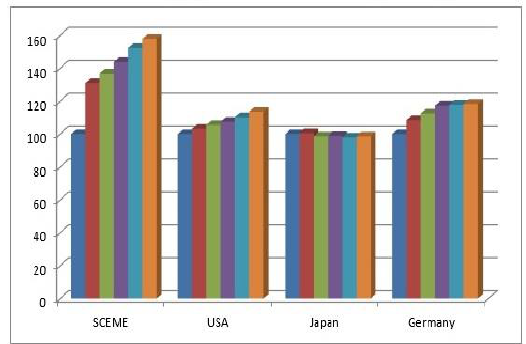
Table 1: Dependence of Profitable Output on